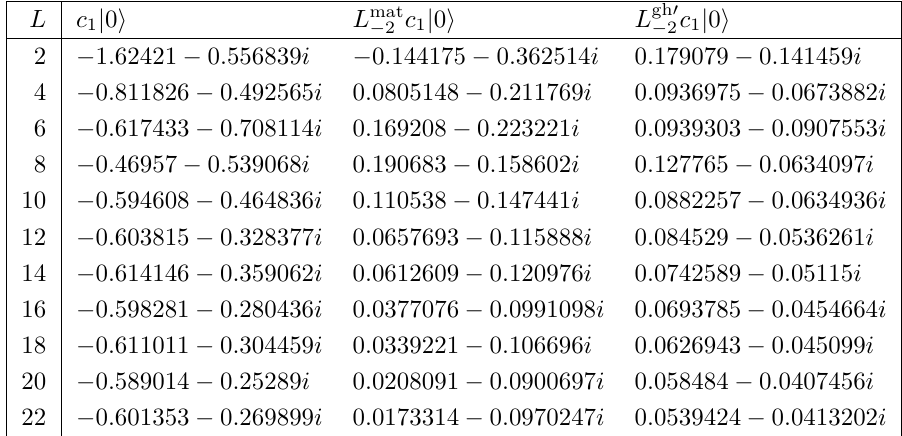
Table 3 . Coefficients of three lowest level states for the “double brane” solution Φ D truncation level L .